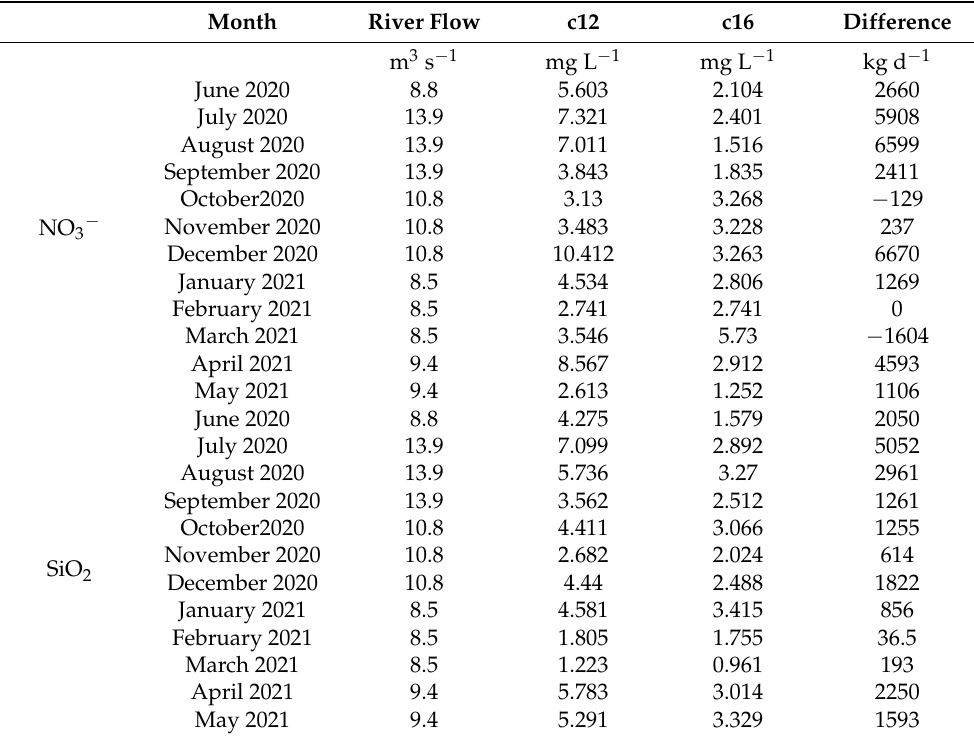
Table 2. NO 3 − and SiO 2 concentrations and loads during the hydrological year 2020–2021. The c12 and c16 data represent the Mincio River concentrations, while their difference is expressed as daily load.